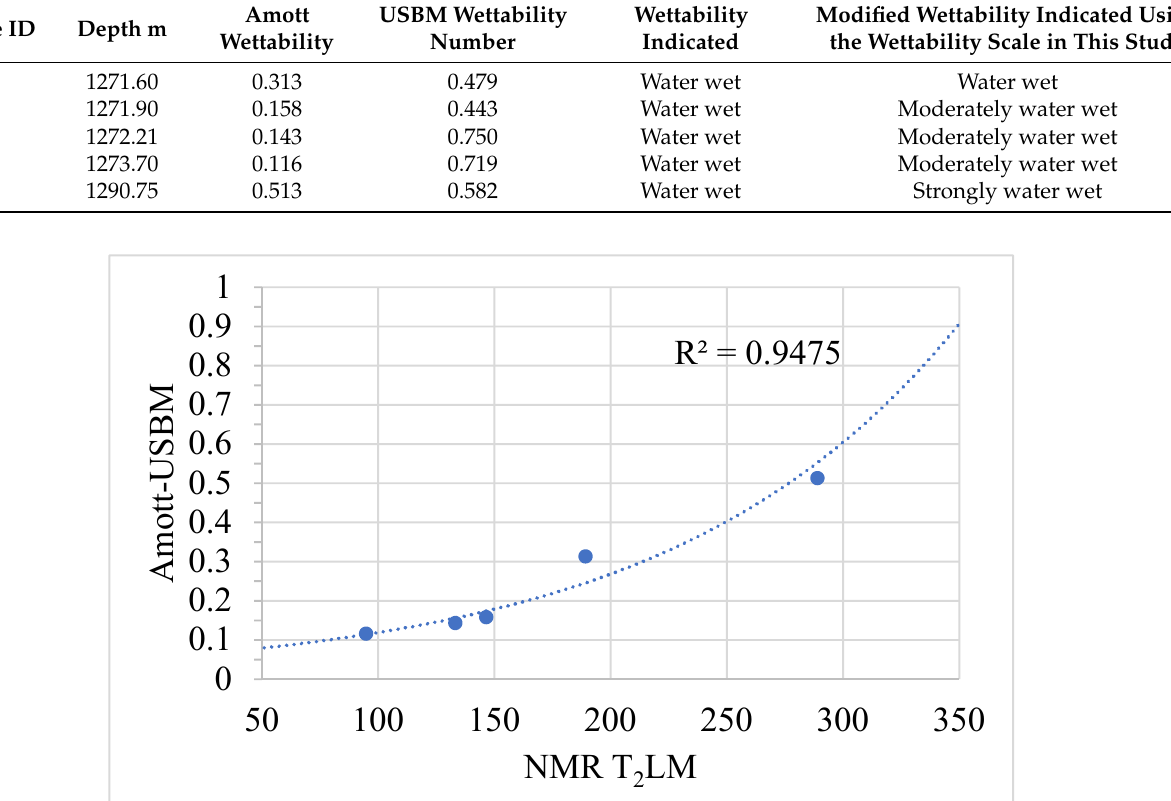
Table 5. Initial wettability states and modified wettability states for core samples.